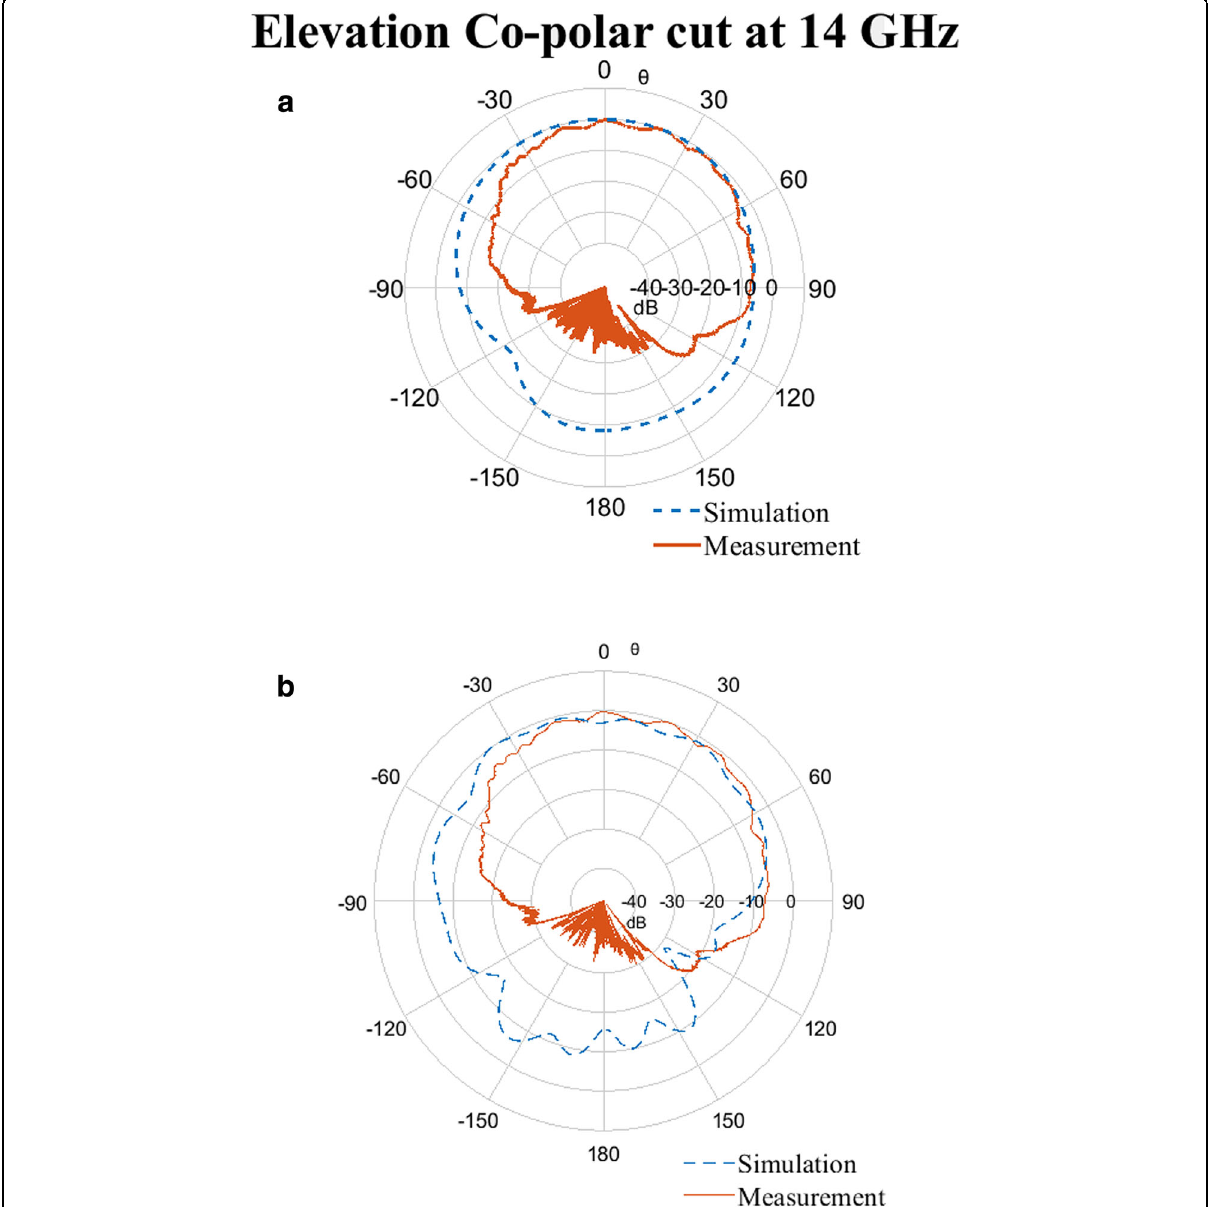
Fig. 24 Comparison of simulated and measured elevation cut. a Simulation curve is without anechoic chamber backplate. b Simulation curve is with anechoic chamber